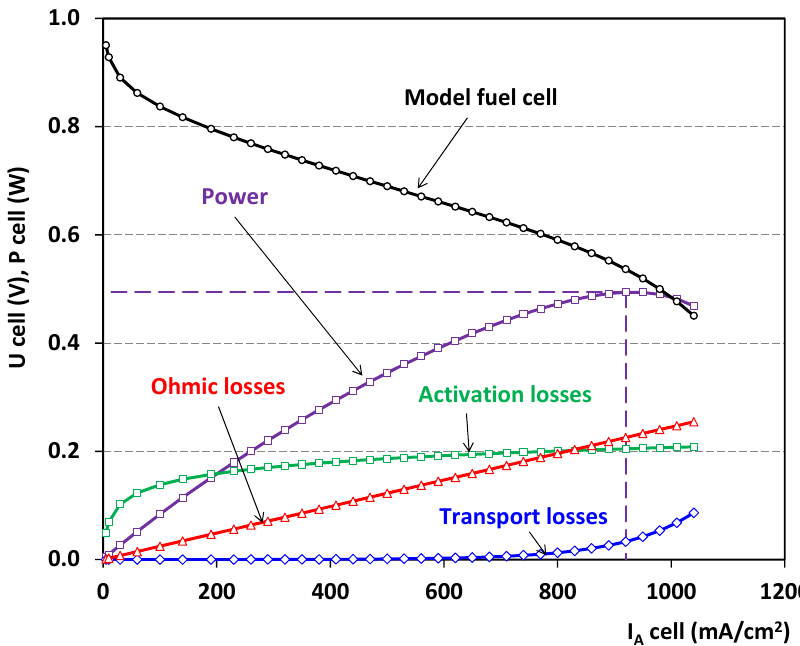
Figure 4. Current_voltage characteristics with the specification of typical losses of a fuel cell.